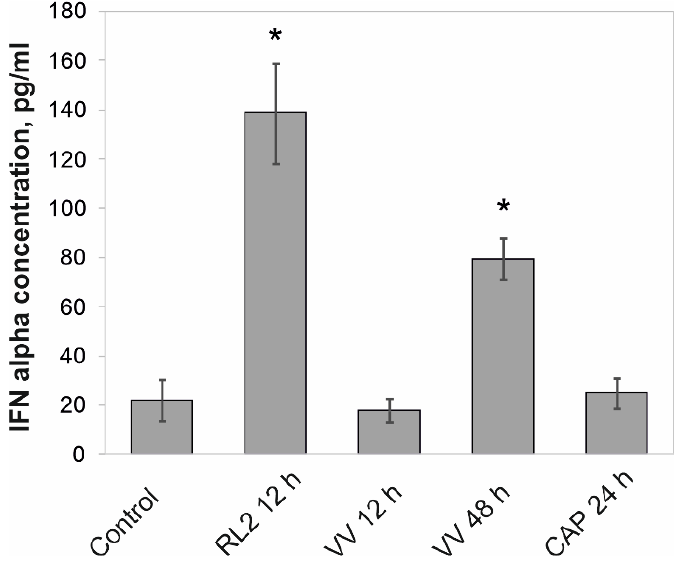
Figure 1. Change in the level of extracellular interferon-alpha (IFN- α ) under the influence of RL2, VV-GMCSF-Lact (VV), and CAP. MX-7 cells were treated with RL2 (0.3 mg/mL, 12 h), VV (0.5 PFU/cell, 12 h and 48 h), or CAP (1 min, helium 9 L/min, 4.9 kV; 24 h after irradiation). Culture medium aliquots from the treated cells were analyzed by ELISA using an IFN-alpha mouse ELISA kit. Statistical differences between the control and the experimental groups are indicated by * for p < 0.05.